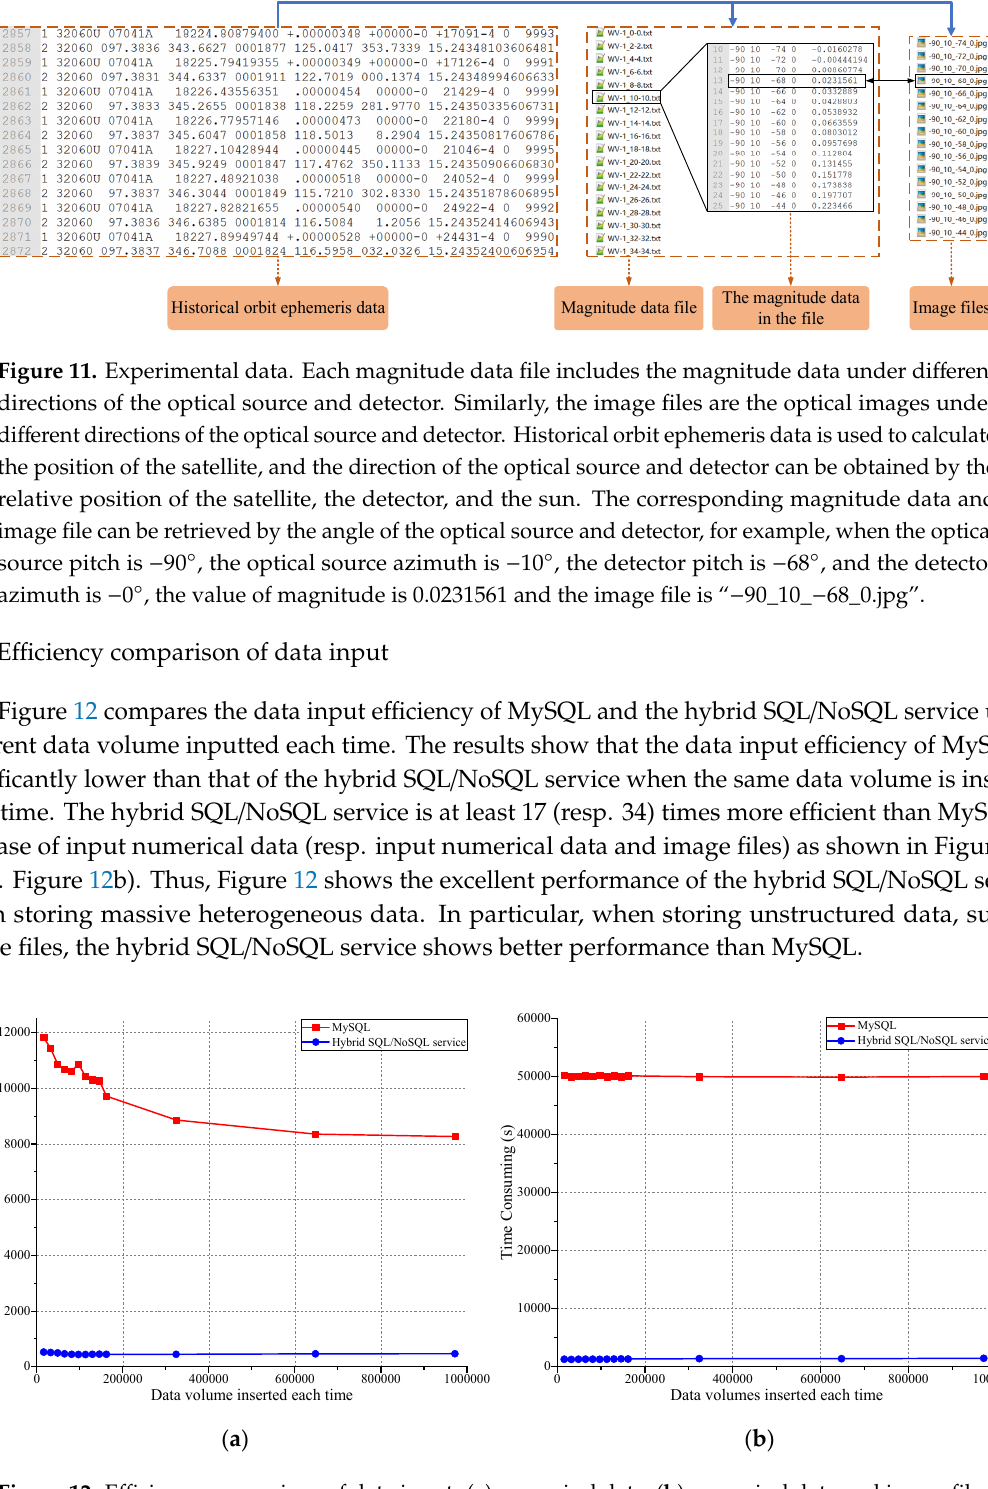
Figure 12. Efficiency comparison of data input: ( a ) numerical data; ( b ) numerical data and image files.